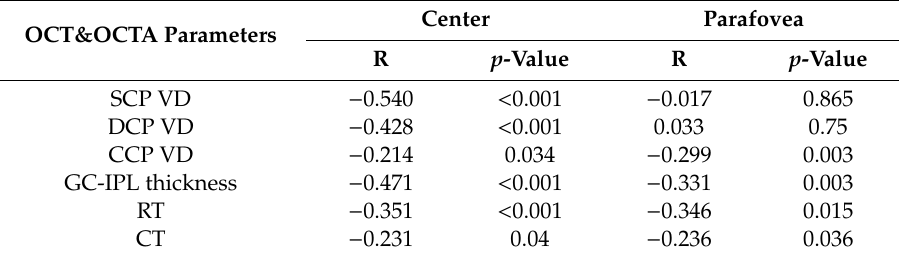
Table 6. Correlation analysis between FAZ area and other parameters. OCT&OCTA